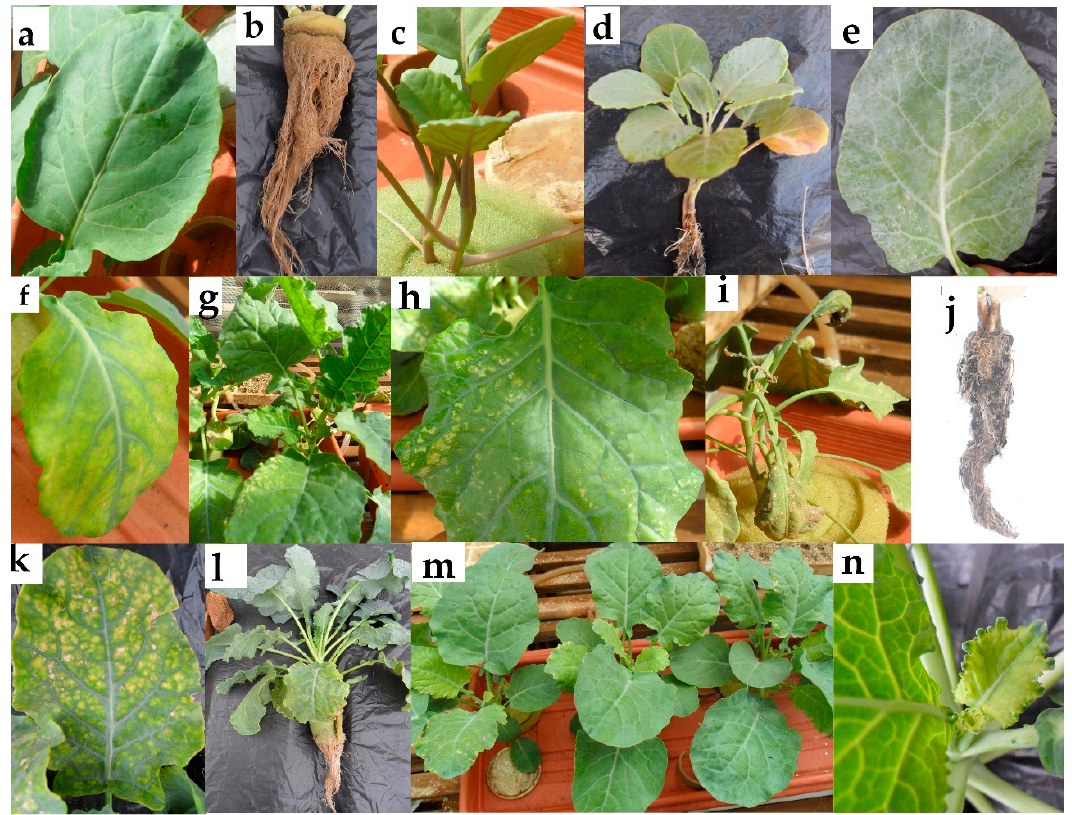
Figure 2. Visual symptoms of nutrient deficiency in broccoli ( Brassica oleracea var. italica L.) plants grown in a complete nutrient solution ( a , b ) and omitting nitrogen ( c , d ), phosphorus ( e , f ), potassium ( g , h ), calcium ( i , j ), magnesium ( k , l ), and sulphur ( m , n ). Plants manifested initial symptoms of P deficiency at 32 DAT with the -P treatment (Table